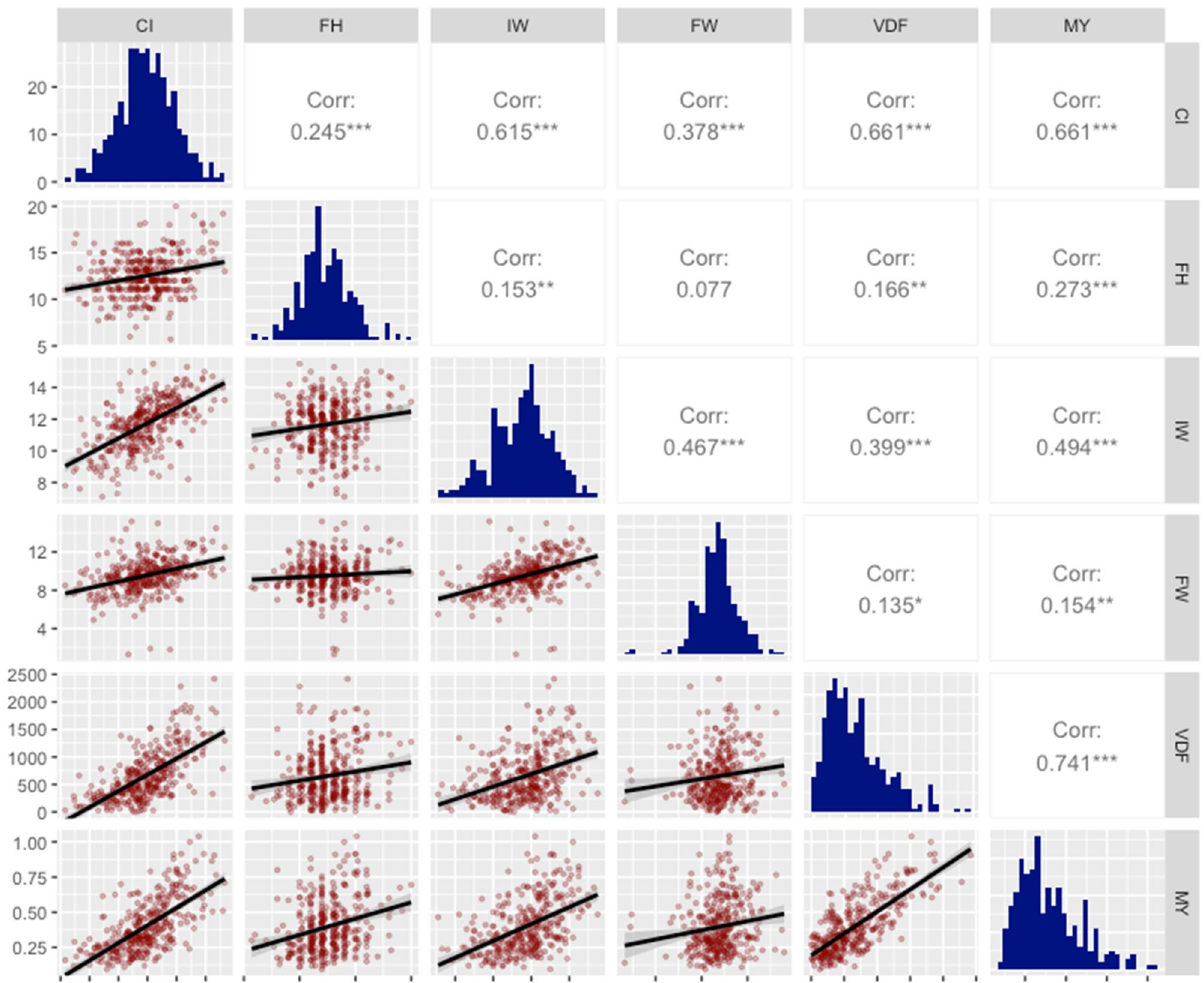
Figure 1. Analysis of the input and output variables. Scatterplots, distributions, and correlation coefficients of initial udder circumference (CI), final udder heigh (FH), initial udder width (IW), final udder width (FW), difference initial and final udder volume (VDF) and milk yield (MY).